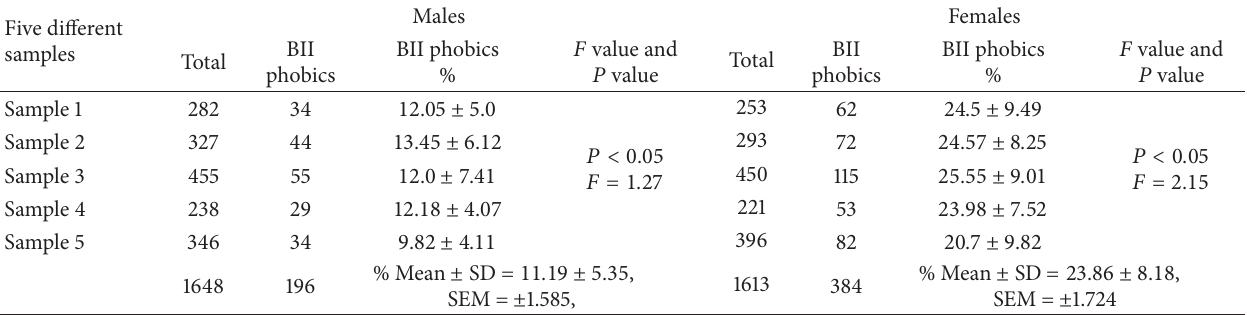
Table 1: Showing the gender wise differences in the percentage of patients suffering from BII phobia in five localities of Aligarh. Five different